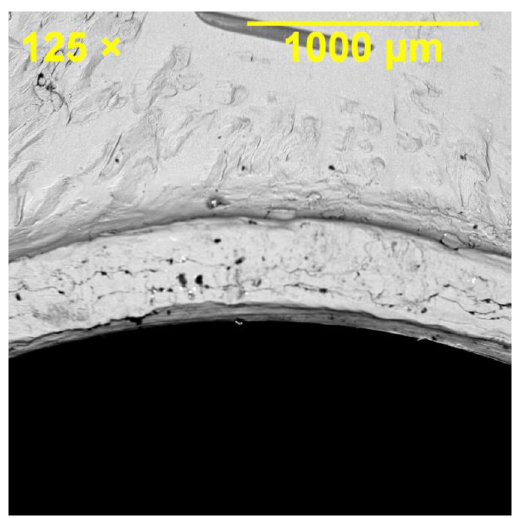
Figure 12. Bearing damage in the hole of the middle plate in SW1e3 specimen, for which bearing failure mode was dominant.